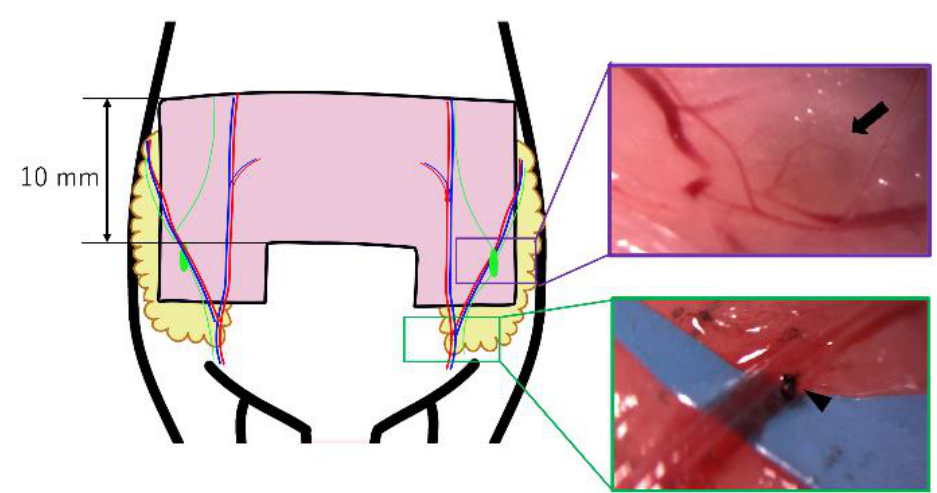
Figure 1. Flap design of the murine model of bilateral pedicled abdominal flaps with groin lymph nodes (LNs). (Purple square) Groin LNs and feeding vessels were identified and included in the flap. The black arrow indicates the left groin LN. (Green square) An artery or vein on the left side was ligated using a 10-0 nylon suture to produce an atrial ischemic or congestive flap. The black arrowhead indicates a venous ligation, which was 0.2 mm in width.